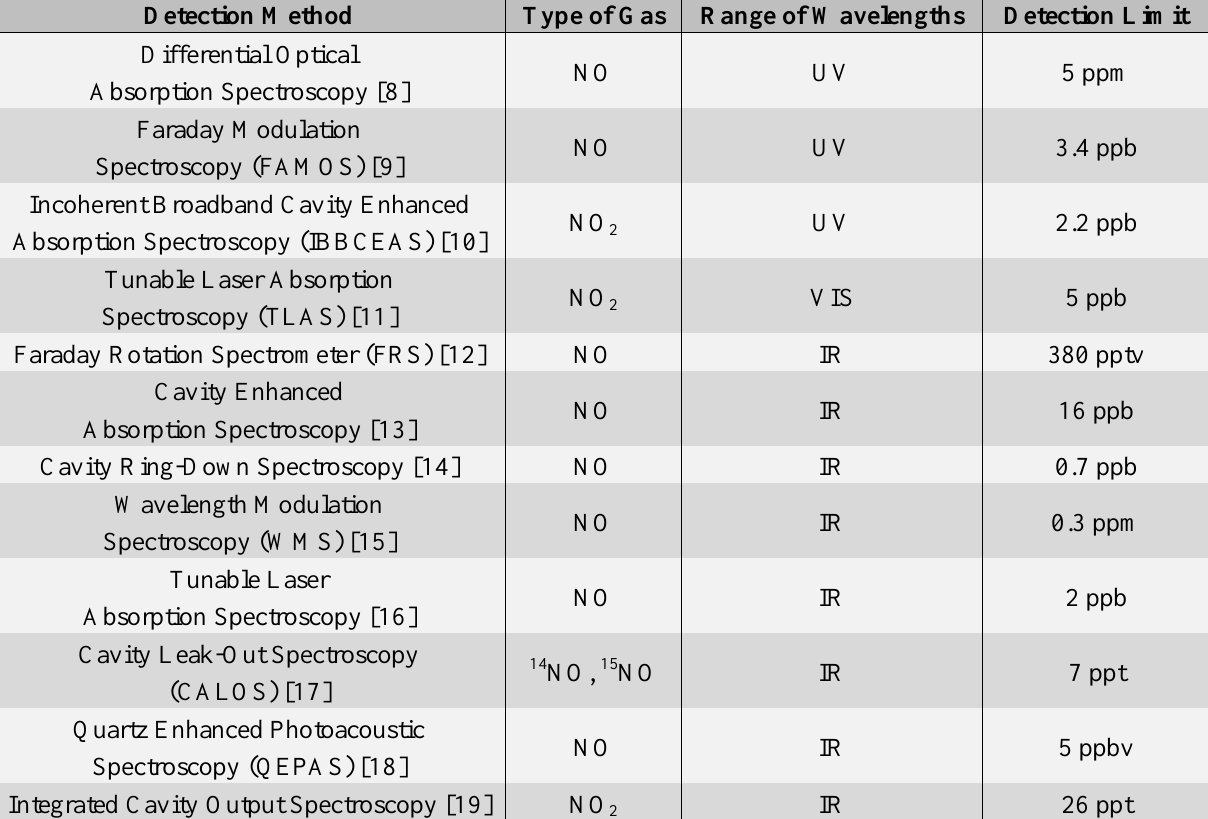
Table 1. Detection limit of technique examples used for NO